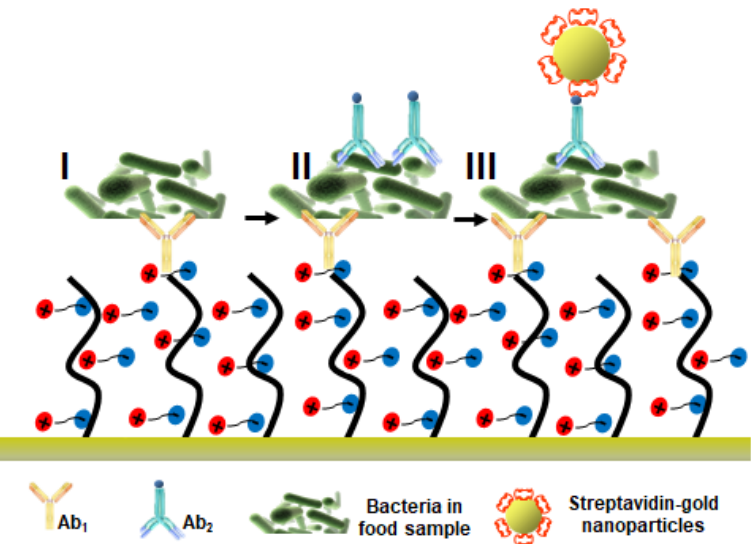
Figure 6. A pictorial illustration of the three-step assay for the detection of bacterial pathogens in food samples. Adapted with permission from Ref. [77]. Copyright (2016) Elsevier.